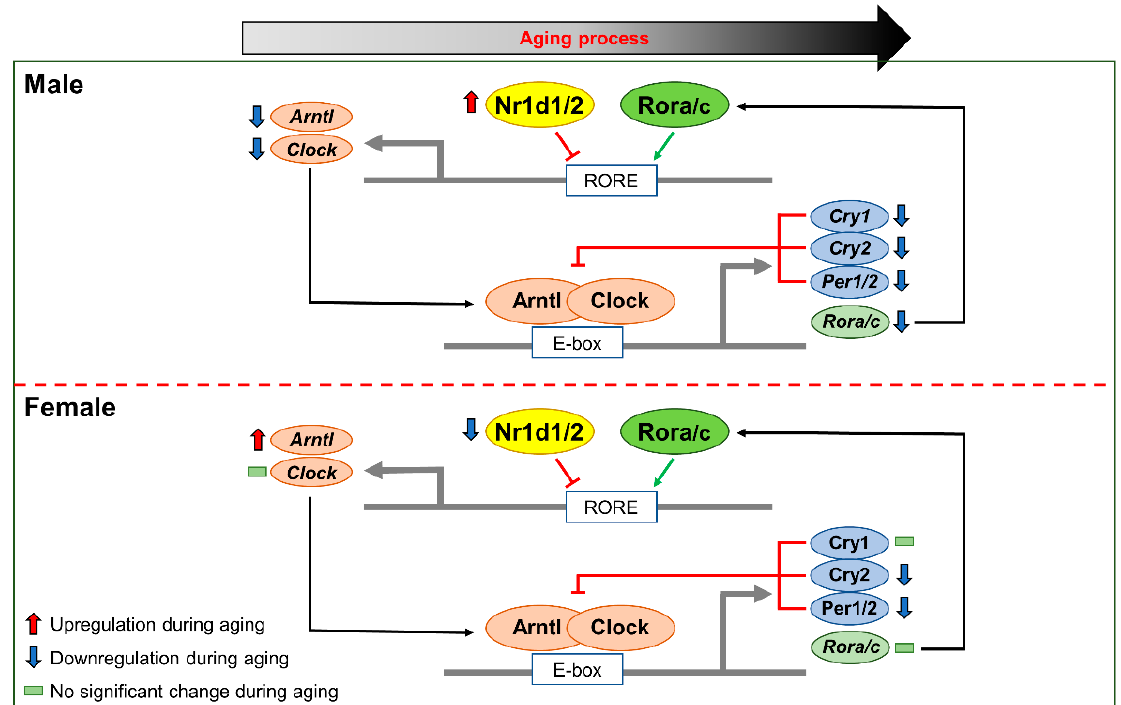
Figure 6. Changes in the expression of circadian genes due to sex-different expression of Nr1d1/2. During the liver aging process, Nr1d1/2 upregulation suppressed expression of Arntl and Clock and resulted in the downregulation of other circadian genes, such as Cry1/2, Per1/2, and Rora/c. Male-specific upregulation of Nr1d1/2 might be involved in the change in circadian rhythm during male liver